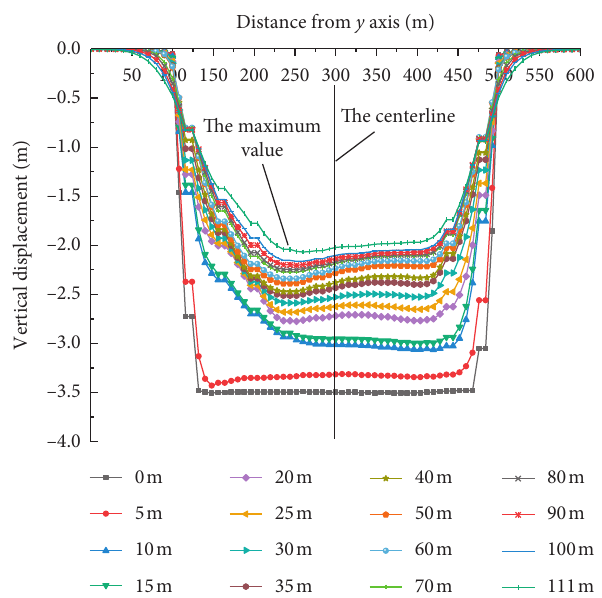
Figure 5: Distribution of vertical displacement on strike obser- vation